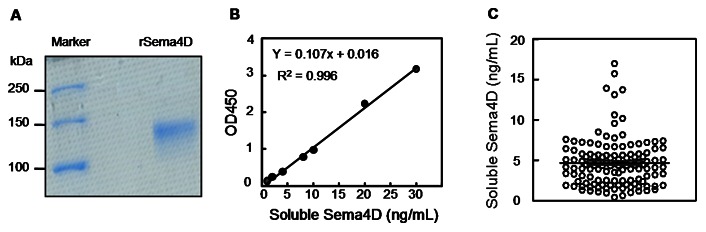
Establishment of a sandwish ELISA to measure soluble Sema4D in human plasma.A. pSecTag2B plasmid containing His-tagged Sema4D coding sequence for amino acids 1–734 was expressed in HEK293T cells. His-tagged Sema4D in the conditioned medium was purified by affinity chromatography. The recombinant Sema4D (rSema4D) migrated as an approximately 120-kDa protein in SDS-PAGE gel. B. An ELISA was developed using coating antibody #4, detecting antibody #3 conjugated with HRP, and rSema4D as a standard. The standard curve was generated under optimized conditions (capture antibody, 10 µg/mL; detection antibody, 200 ng/mL). C. Healthy donors (n = 126), who underwent routine medical check-ups and had no medical history of cardiovascular diseases, were examined for their plasma soluble Sema4D levels as described in Materials and Methods.